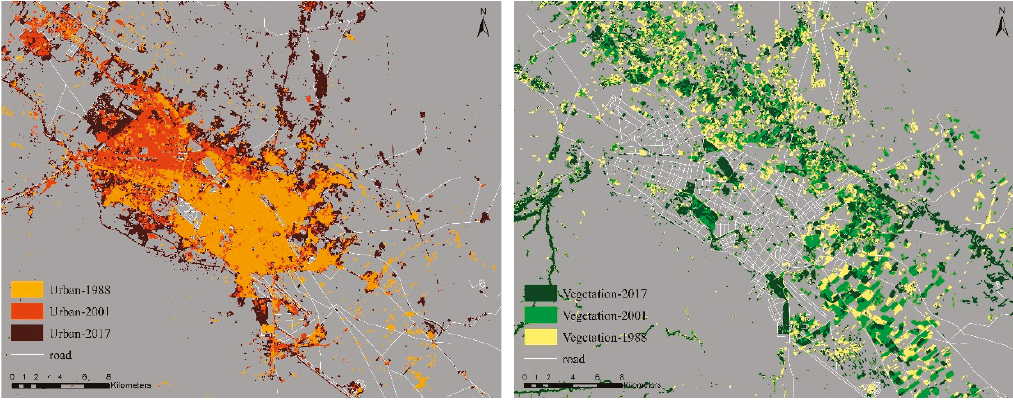
Figure 3. Urban land and vegetation cover in 1988, 2001 and 2017. Table 4. The proportion of the urban land, vegetation cover and soil in the study